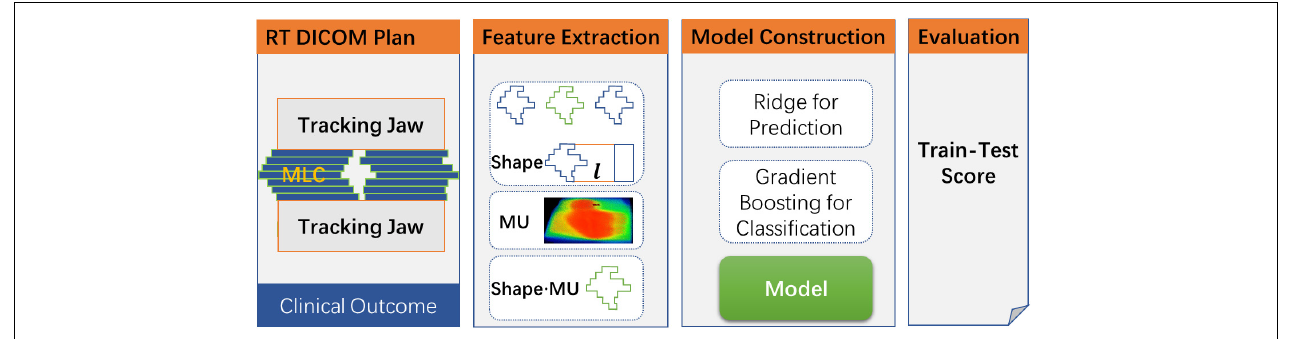
FIGURE 1 | The overall workflow for the